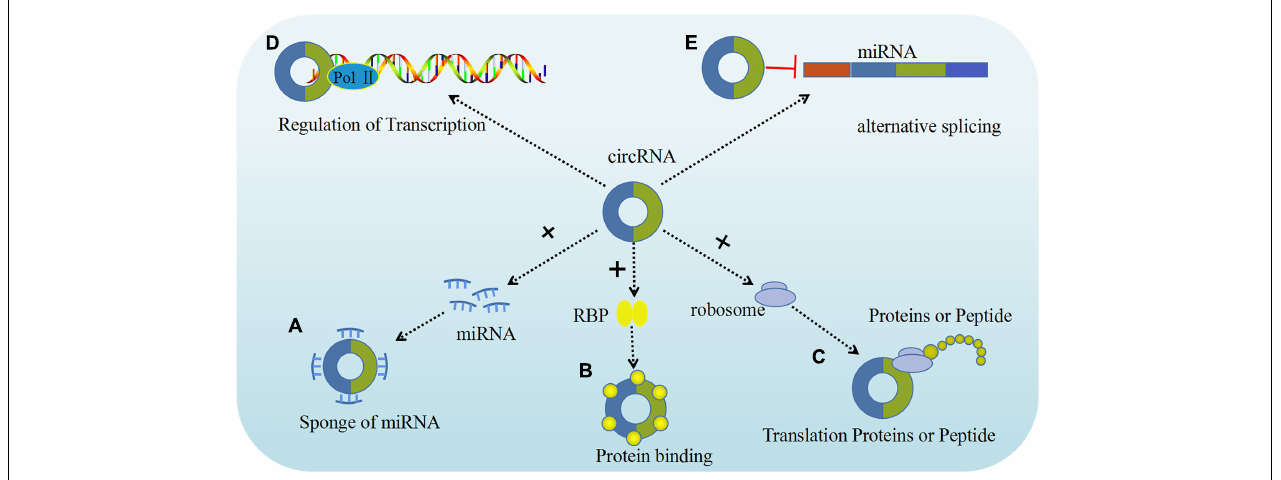
FIGURE 2 | The functions of circRNAs. Five major functions of circRNAs have been identified, including: (A) Sponge of miRNA; (B) Proteins binding; (C) Translation proteins or peptide; (D) Regulation of transcription; (E) Alternative splicing (Yang et al., 2020).